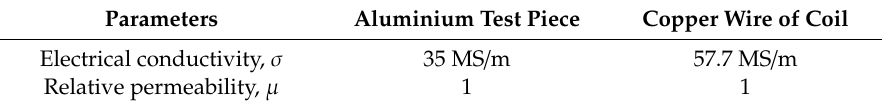
Table 1. Electromagnetic parameters used in the analysis.